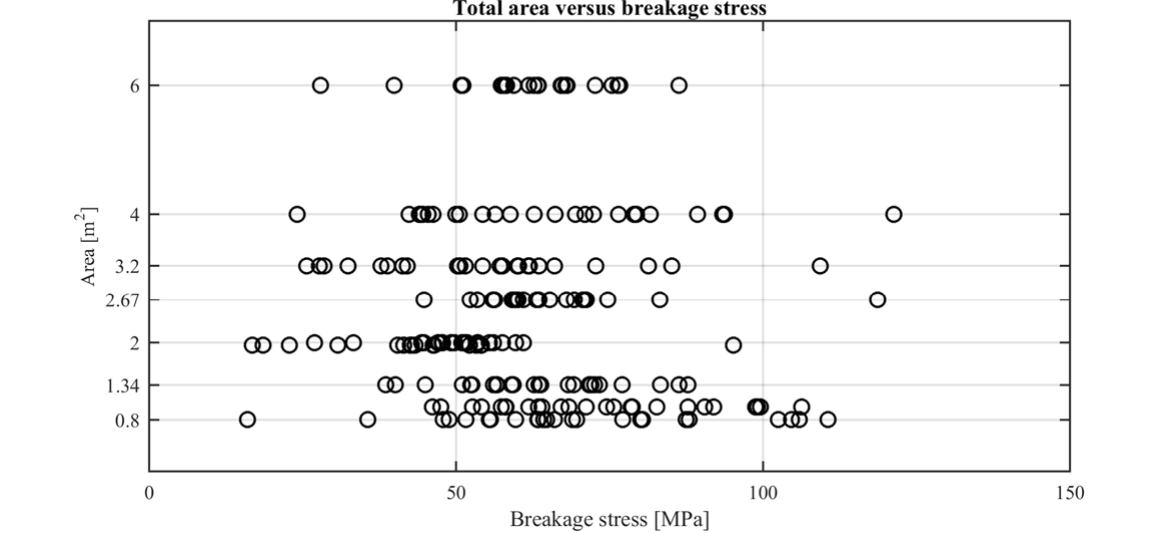
Fig. 5 Data results on glass breakage stresses versus total surface area from Calderone